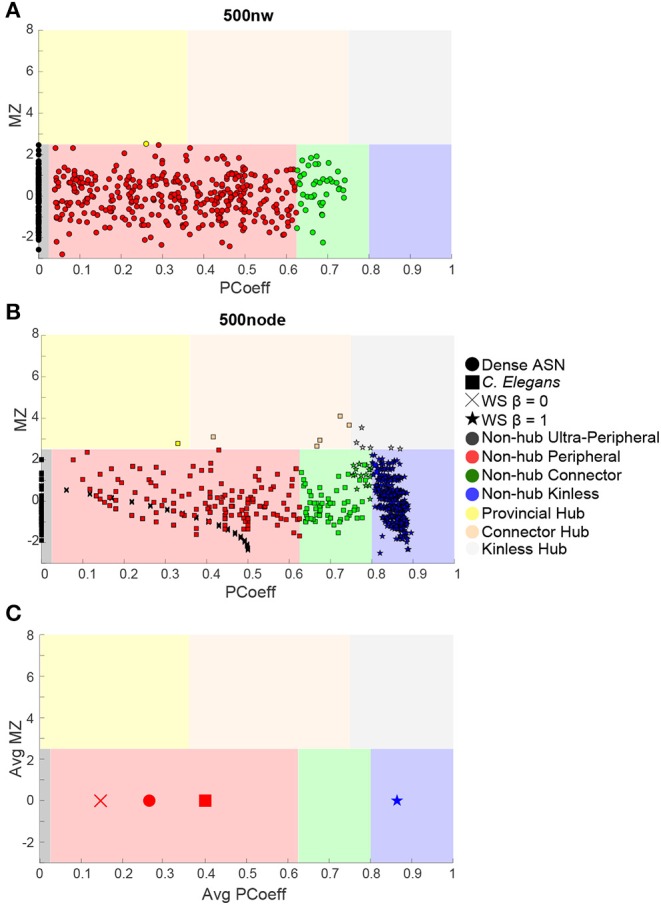
Guimera-Amaral (2005) Cartographic-Space: Within-Module Degree z-Score (MZ) and Participant Coefficient (PCoeff). The dark-gray region (bottom left) refers to ultra-peripheral nodes (i.e., nodes with only one or few connections within a module); The light red region refers to peripheral nodes (i.e., nodes that are non-hubs and are only connected within a module); The green region refers to non-hub connector nodes (i.e., nodes that are connected to other modules but are not hubs); The blue region (bottom right) refers to non-hub kinless nodes (i.e., non-hub nodes not belonging to a particular module); The yellow region (top left) refers to provincial hubs (i.e., hub nodes that are highly connected within a module, but not between modules); The cream region refers to connector hubs (i.e., nodes that are highly connected between modules, but not necessarily within modules); the light-gray region (top right) refers to kinless hubs (i.e., hubs not belonging to a particular module). Regions are adapted from Guimerà and Amaral (2005). See Box 1 for example nodes. (A) 500 nw ASN networks. Each colored dot is the mean MZ and PCoeff for the most dense (Avg DEG = 40.66) variations of ASNs. (B) 500 node WS networks and C. elegans networks. Squares represent the MZ and PCoeff for C. elegans. Stars and crosses represent the MZ and PCoeff values for WS networks with β = 0 and 1, respectively. (C) Average PCoeff and MZ scores for each type of network.